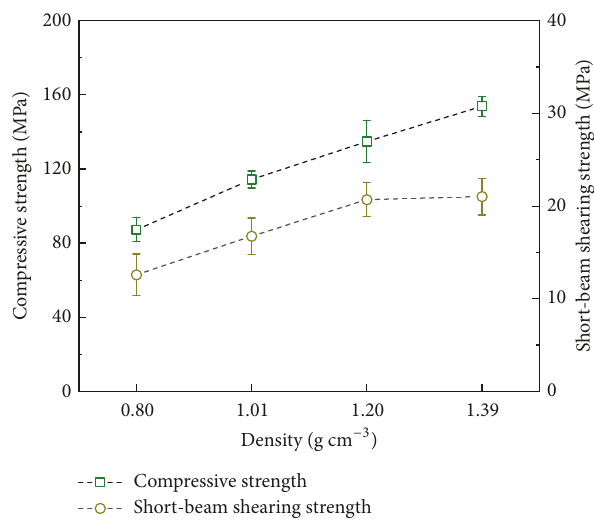
Figure 7: Compressive and short-beam shearing properties of scrimbers with various